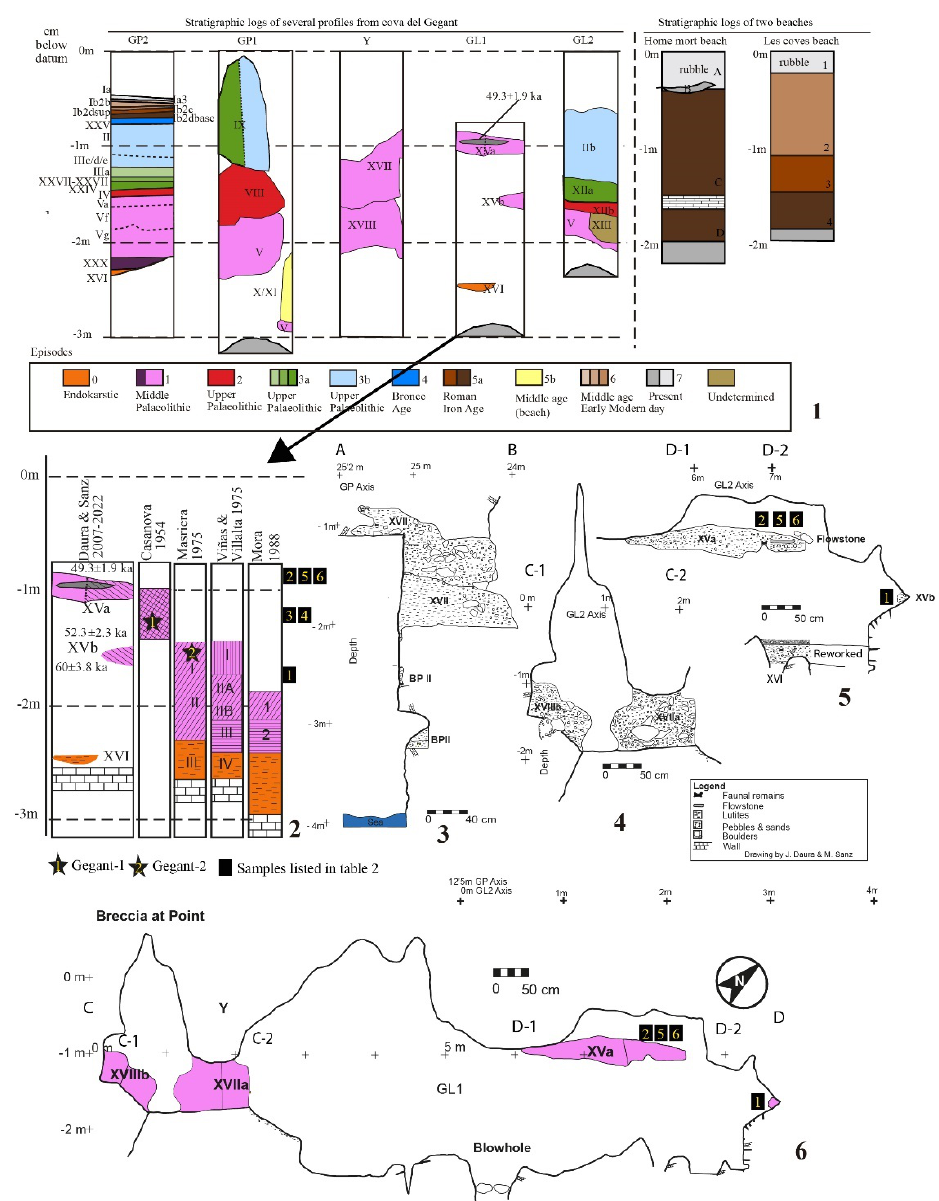
Figure 3. ( 1 ): Stratigraphy and correlation of the Cova del Gegant’s logs. ( 2 ): GL1 logs integrating previous excavations. ( 3 ): Transversal profile in the point Y breccia. ( 4 ): Transversal profile in the point Y breccia. ( 5 ): GL-1 section. ( 6 ): GL-1 cross section. point Y breccia. ( 5 ): GL-1 section. ( 6 ): GL-1 cross